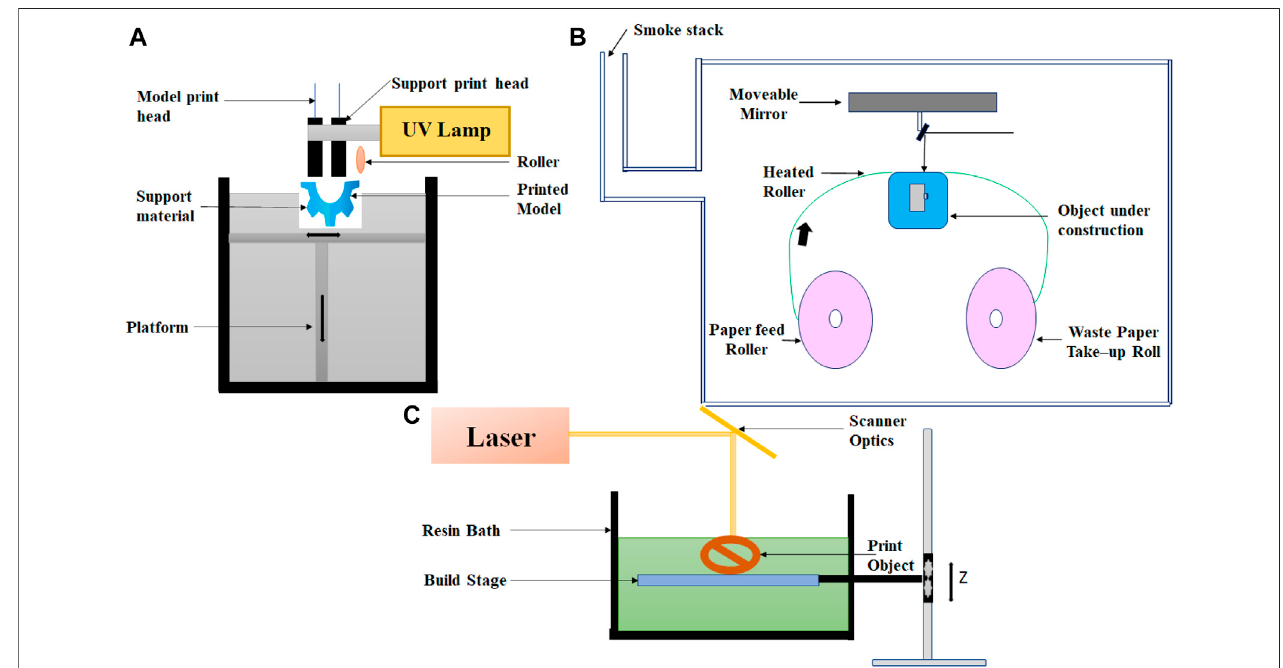
FIGURE 3 | Schematic for various 3D-printed techniques. (A) PolyJet 3D printing, (B) laminated object manufacturing, and (C) direct laser writing.